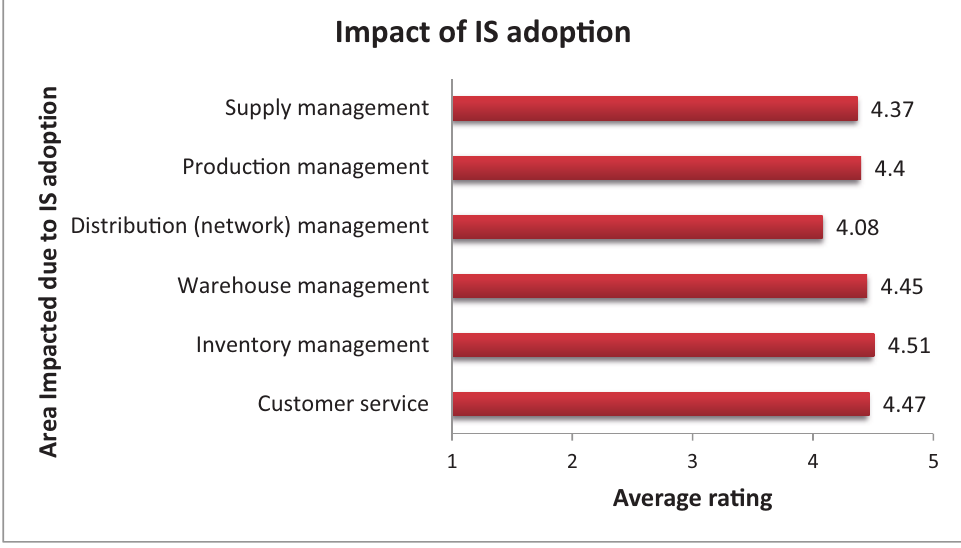
Figure 3. Impact of IS